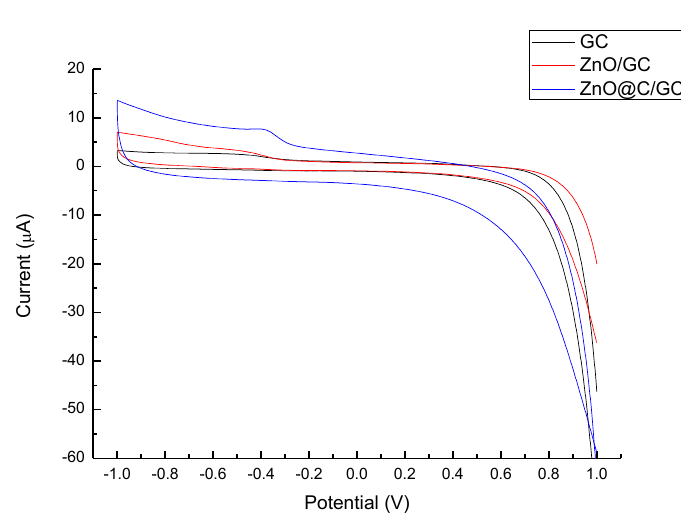
Figure 7. CV profiles of GC, ZnO/GC and ZnO@C/GC electrodes for 1 mM glucose sensing.